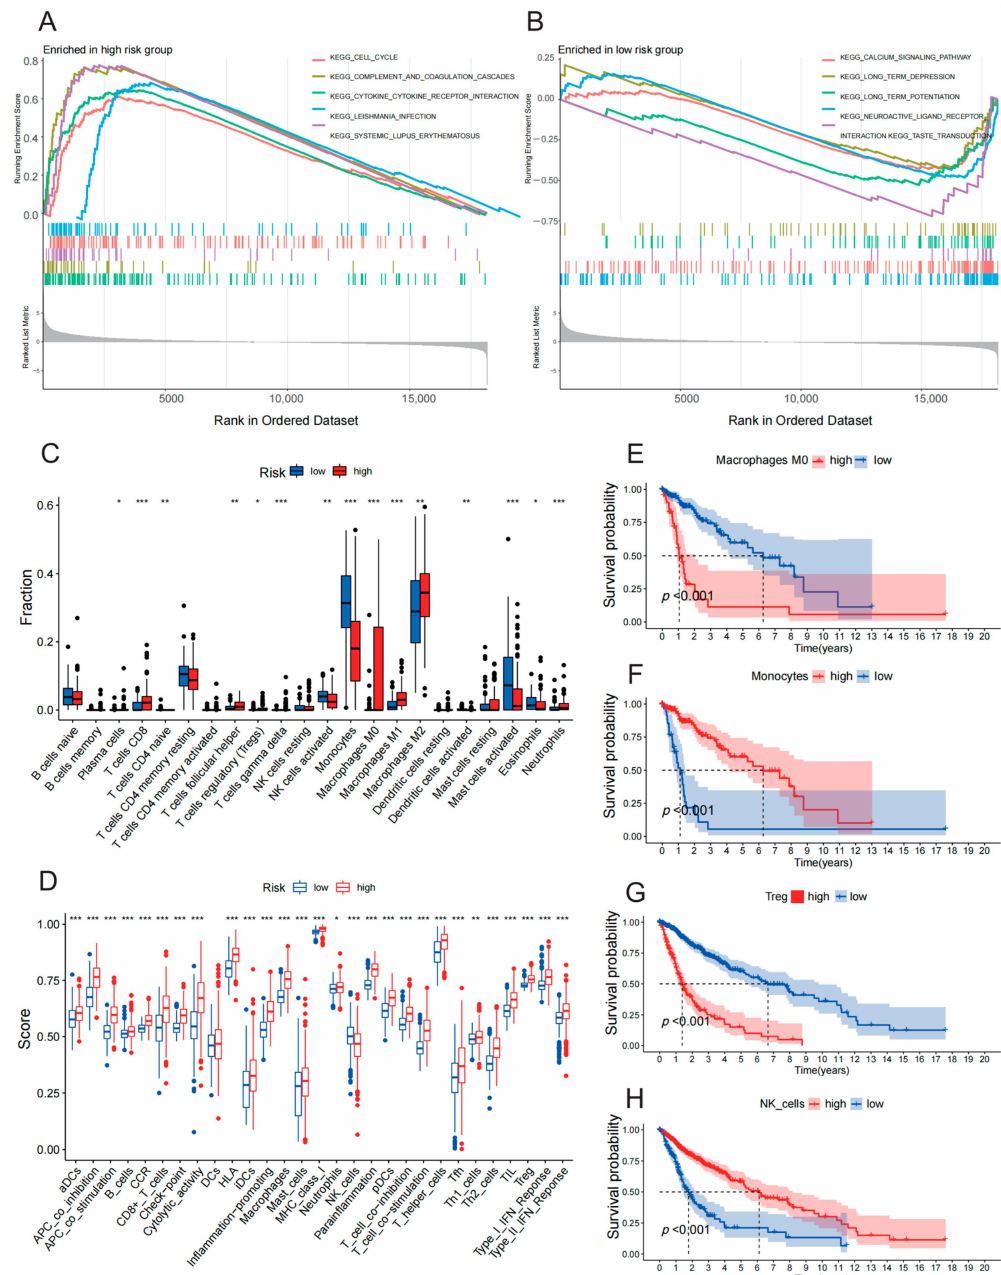
Figure 4. Landscapes of the tumor immune microenvironment. ( A ) Gene sets enriched in the high-IGRPS subgroup. ( B ) Gene sets enriched in the low-IGRPS subgroup. ( C ) The relative infil- tration fraction of 22 immune cells in different subgroups. The distribution of 15 immune cells in the two subgroups was statistically different (ns: not significant, * p < 0.05, ** p < 0.01, *** p < 0.001. ( D ) Enrichment abundance of immune function features in different subgroups. ( E – H ) Kaplan–Meier curves of M0 macrophage, monocyte, Treg, and NK cell infiltration